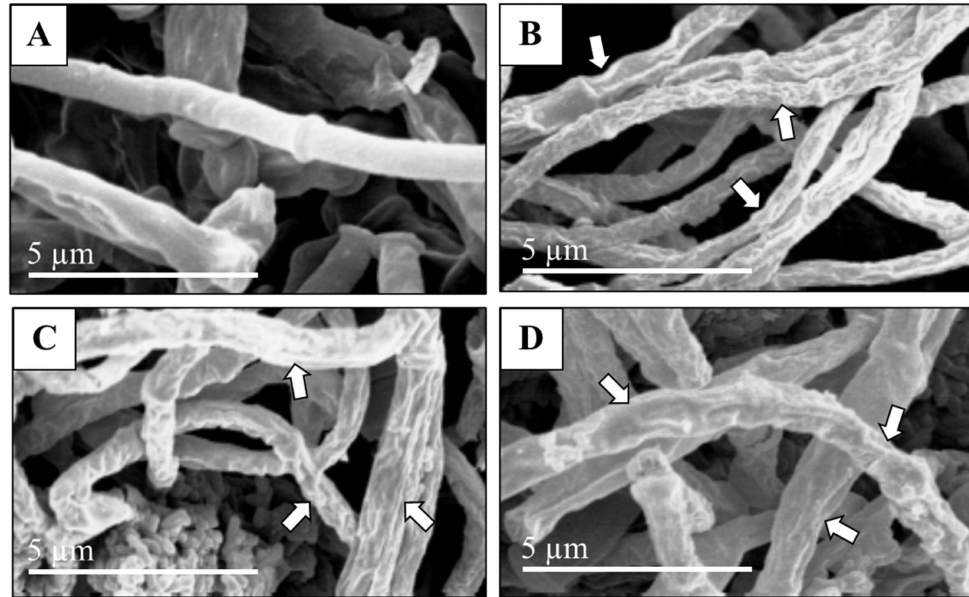
Figure 10. Scanning electron micrographs of FOL treated with U. lactuca , S. dentifolium , and G.